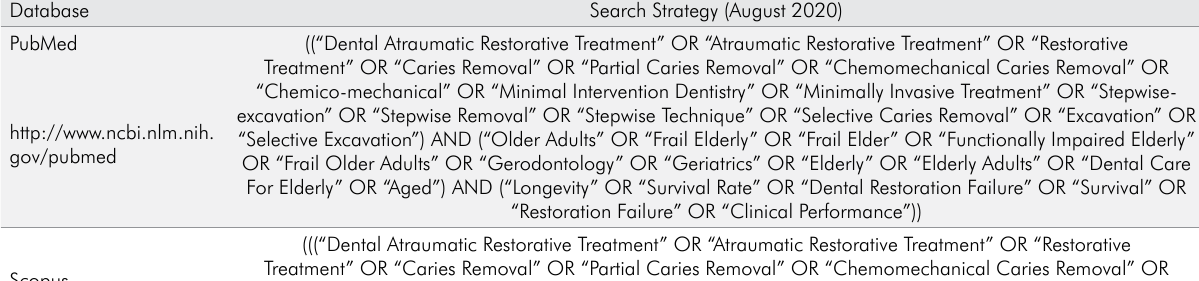
Table 1. Strategies for database